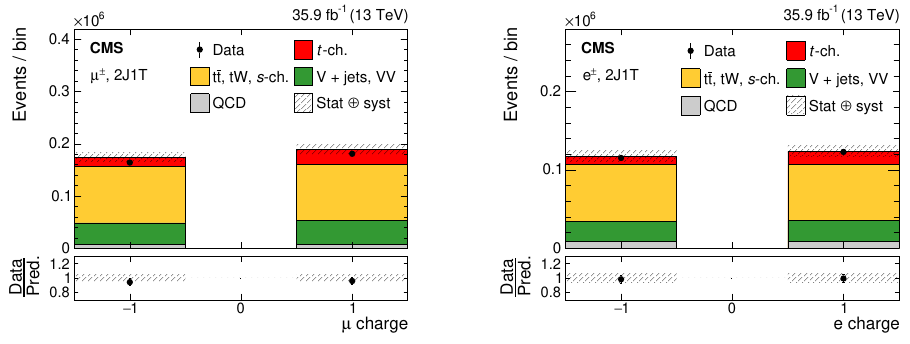
Figure 2 . Event yields corresponding to positively and negatively charged muons (left) and elec- trons (right) in the final states obtained for the 2J1T category from data (points) and from simulated signal and background processes (colored histograms). The vertical bars on the points show the statistical uncertainty in the data, and the cross-hatched bands denote the quadrature sum of the statistical and systematic uncertainties in the predictions. The lower panels show the ratio of the data to the